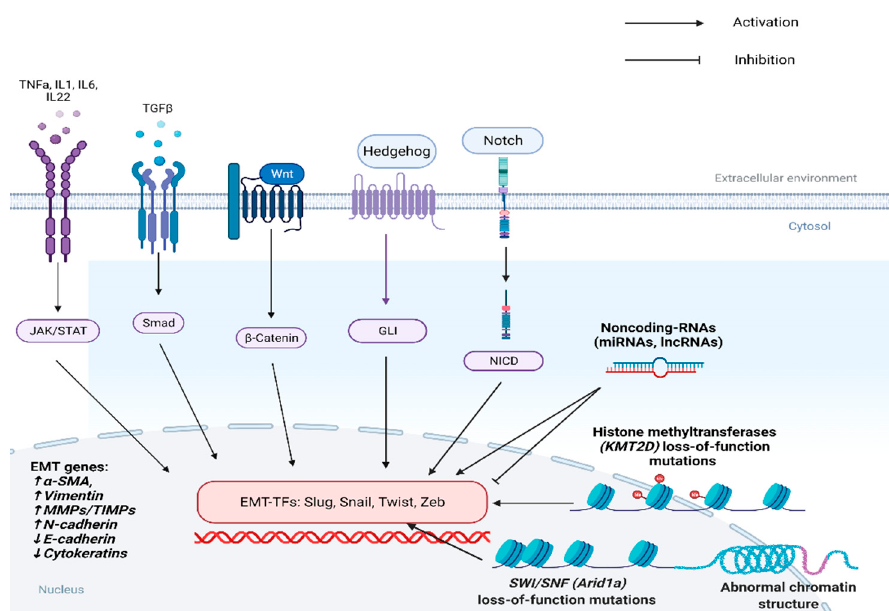
Figure 2. Multiple signaling pathways and epigenetics factors, including histone methyltransferases, chromatin remodeling complexes, and noncoding-RNA molecules control EMT in PDAC. (a-SMA: alpha Smooth Muscle Actin, MMPs: Matrix Metalloproteinases, TIMPs: Tissue Inhibitors of Metallo-